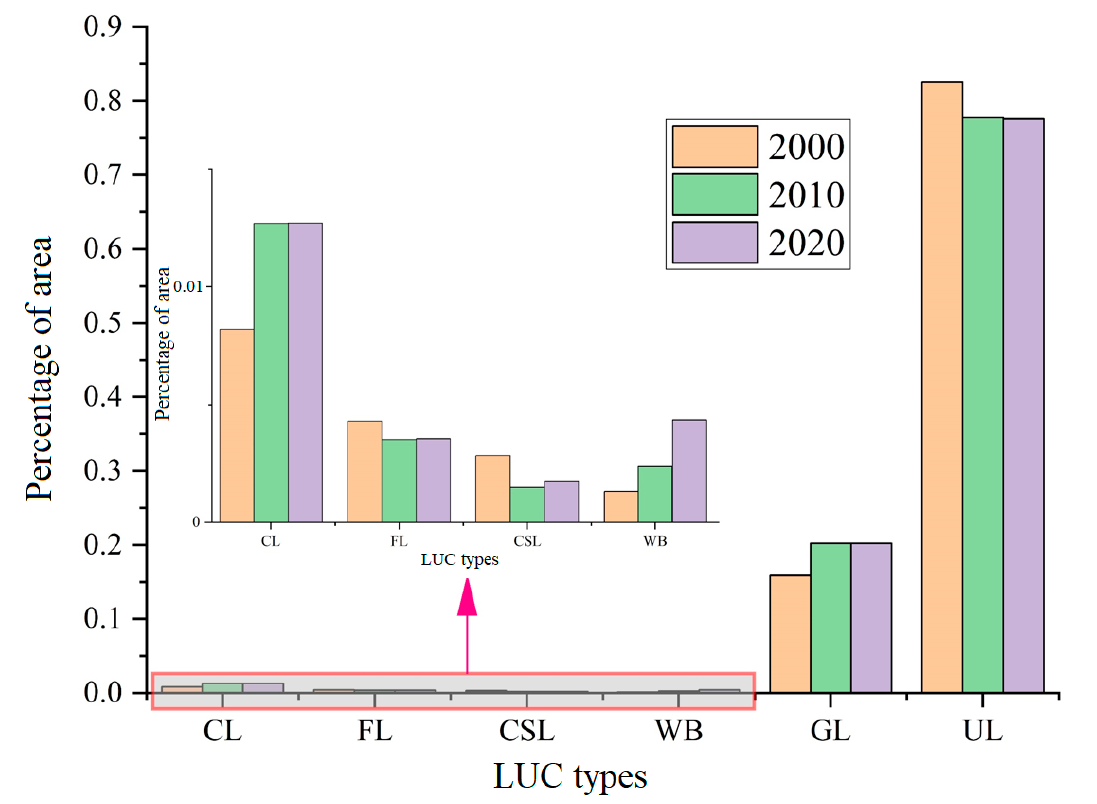
Figure 2. The proportions of each LUC type to area in Hami city. CL, FL, CSL, WB, GL and UL are cropland, forest land, construction land, water body, grassland and unused land, respectively.